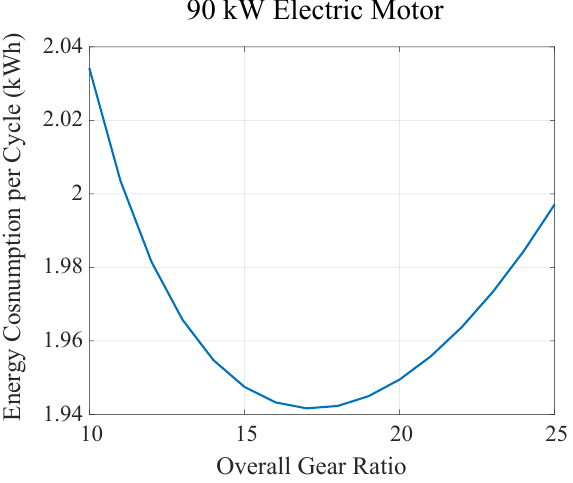
Figure 8. Variation in fuel consumption as a function of the total gear ratio (gearbox, differential and final drive), with a maximum power of 90